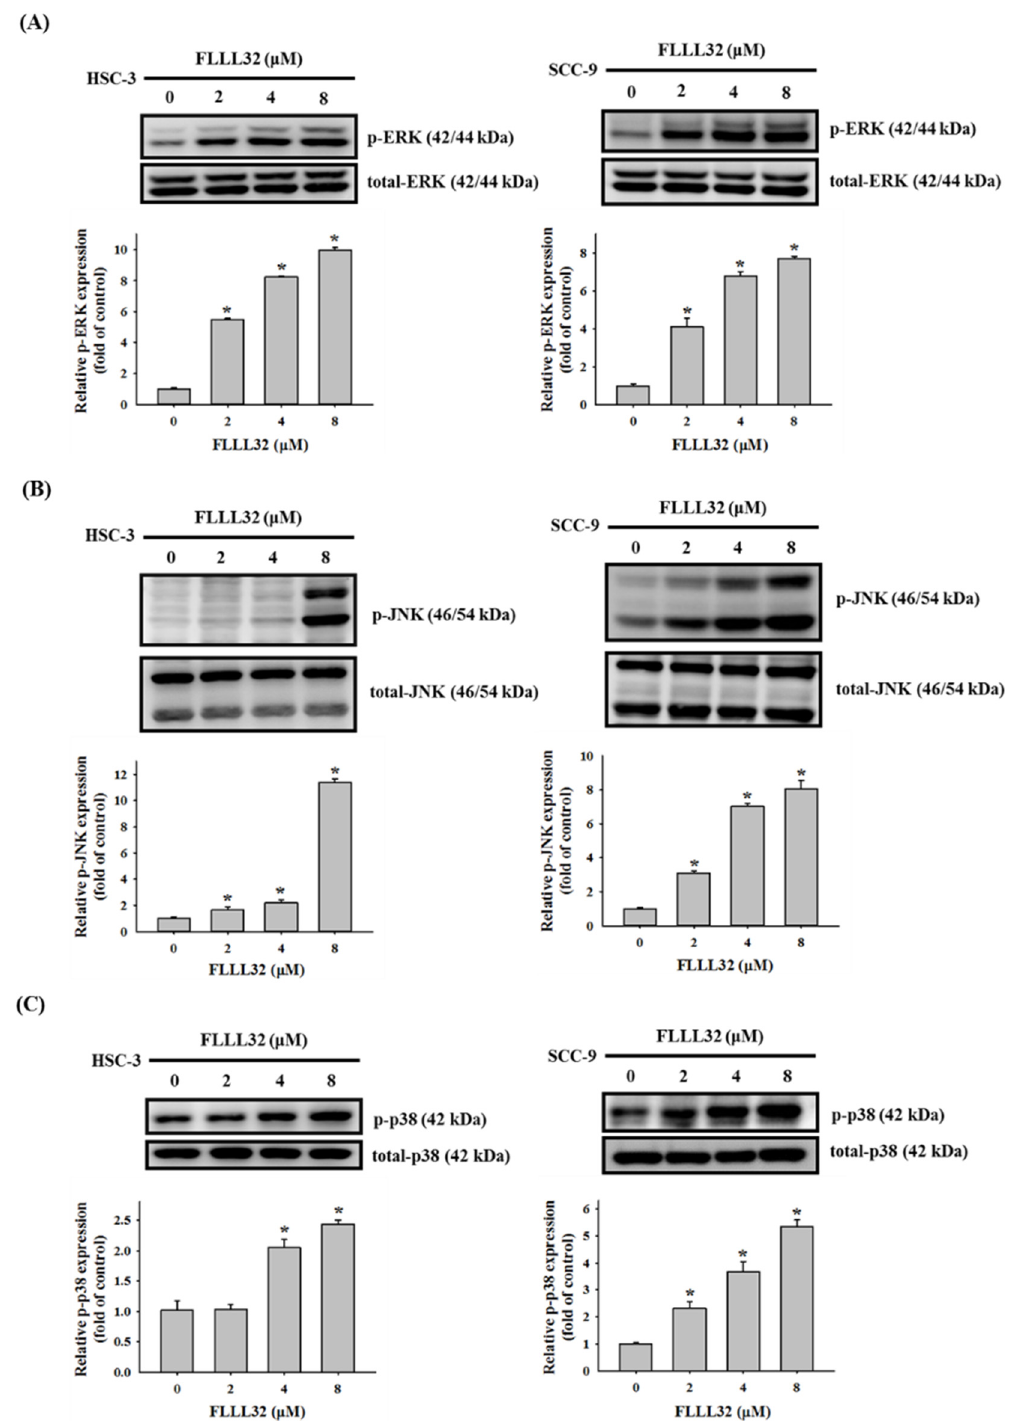
Figure 6. FLLL32 induces the activation of p-ERK, p-JNK, and p-p38 in oral cancer cells. HSC-3 and SCC-9 cells were treated with FLLL32 (0, 2, 4, or 8 μ M) for 6 h, and the protein levels were analyzed by Western blot and then quantified by Image J. ( A ) Protein levels of p-ERK and total ERK. ( B ) Protein levels of p-JNK and total JNK. ( C ) Protein levels of p-p38 and total p38. The total protein levels of ERK, JNK, and p38 were used to adjust the quantitative results of protein levels; * p < 0.05 compared with the vehicle group.